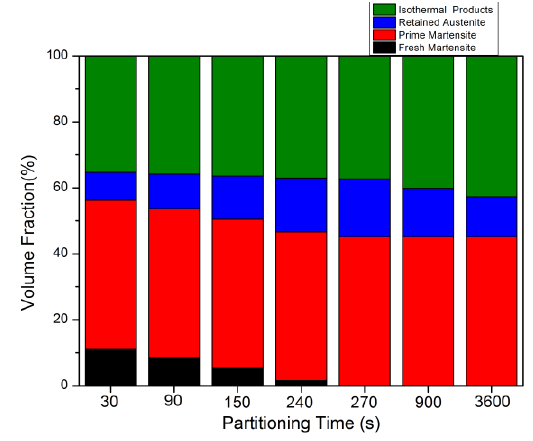
Figure 6. Metals 2020 , 10 , x FOR PEER REVIEW